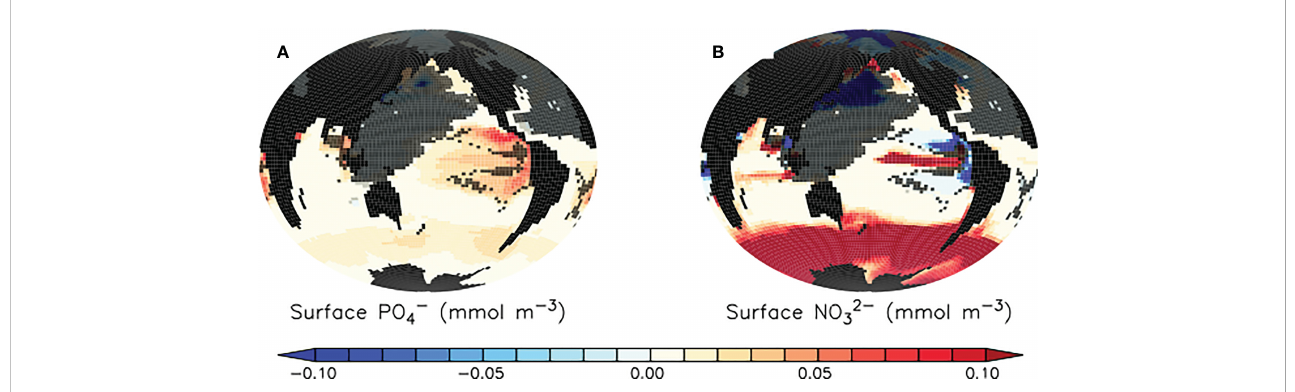
FIGURE 6 Model ensemble mean differences (SLOW small - CNTL) in simulated surface phosphate (A) and nitrate (B) at the year 2100. Trends are robust except for where they are shaded in dark grey. Trends in regions shaded in dark grey also do not agree in sign across the model ensemble. Differences in SLOW big - CNTL are provided as Supplemental Figure